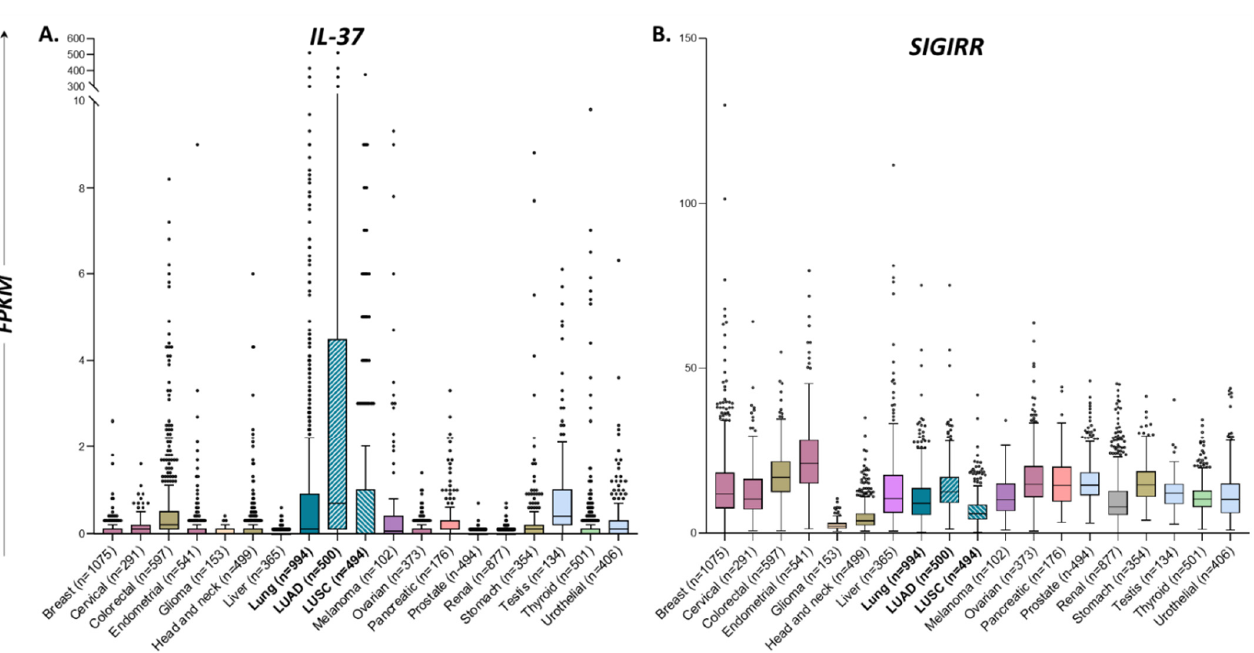
Figure 1. Box and Tukey whiskers diagrams showing the differential distribution of IL-37 ( A ) and SIGIRR ( B ) expression levels (FPKMs), as analyzed by RNA sequencing in human tumor samples